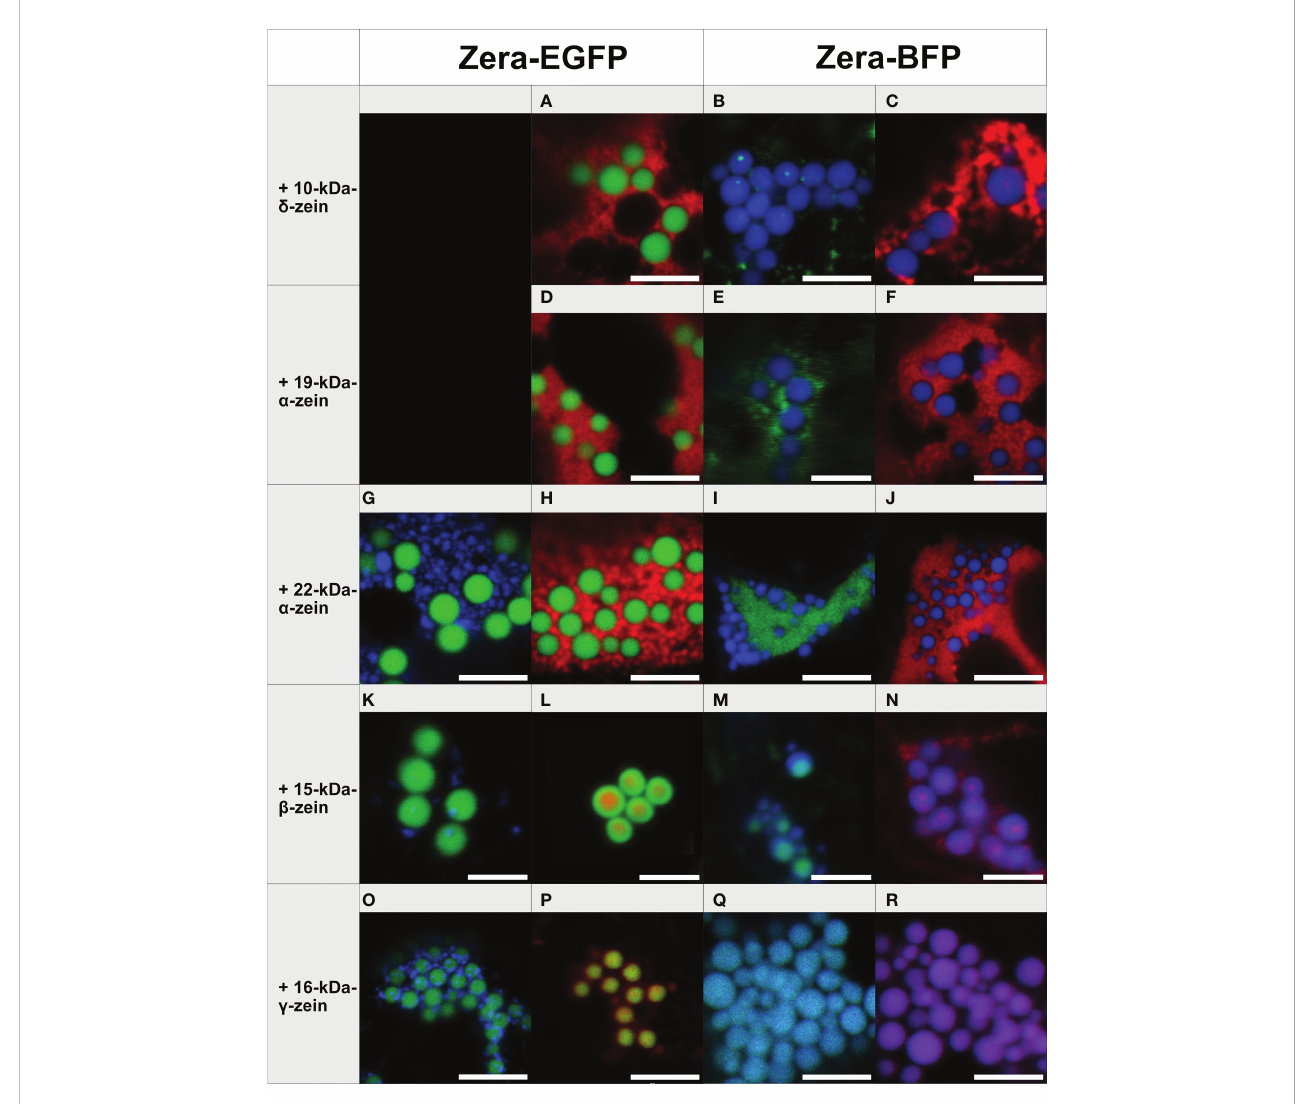
FIGURE 1 Co-expression of individual zeins with Zera-XFP in different fl uorophore combinations (representative images recorded with confocal laser scanning microscopy, merged fl uorescence channels). First panel: Zera-EGFP co-expressed with BFP-fusions of the zeins listed on the left. Second panel: Zera- EGFP co-expressed with mCherry-fusions of the zeins listed on the left. Third panel: Zera-BFP co-expressed with EGFP-fusions of the zeins indicated on the left. Fourth panel: Zera-BFP co-expressed with mCherry-fusions of the zeins listed on the left. (A-C) Zera-XFP + 10-kDa- d -zein-XFP, (D-F) Zera-XFP + 19-kDa- a -zein-XFP, (G-J) Zera-XFP + 22-kDa- a -zein-XFP, (K-N) Zera-XFP + 15-kDa- b -zein-XFP, (O-R) Zera-XFP + 16-kDa- g -zein-XFP. Scale bar 5 µm. Individual/single channel data are presented in Supplementary Figures